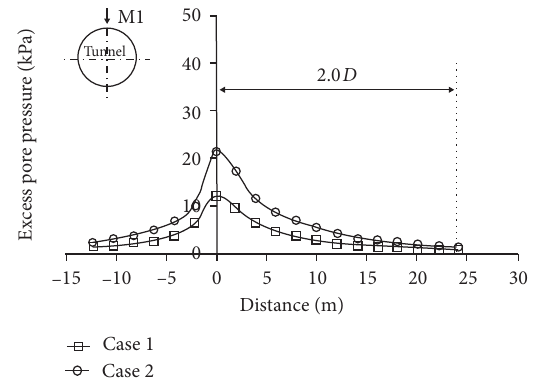
Figure 13: Distribution of excess pore water pressure under dif- ferent support